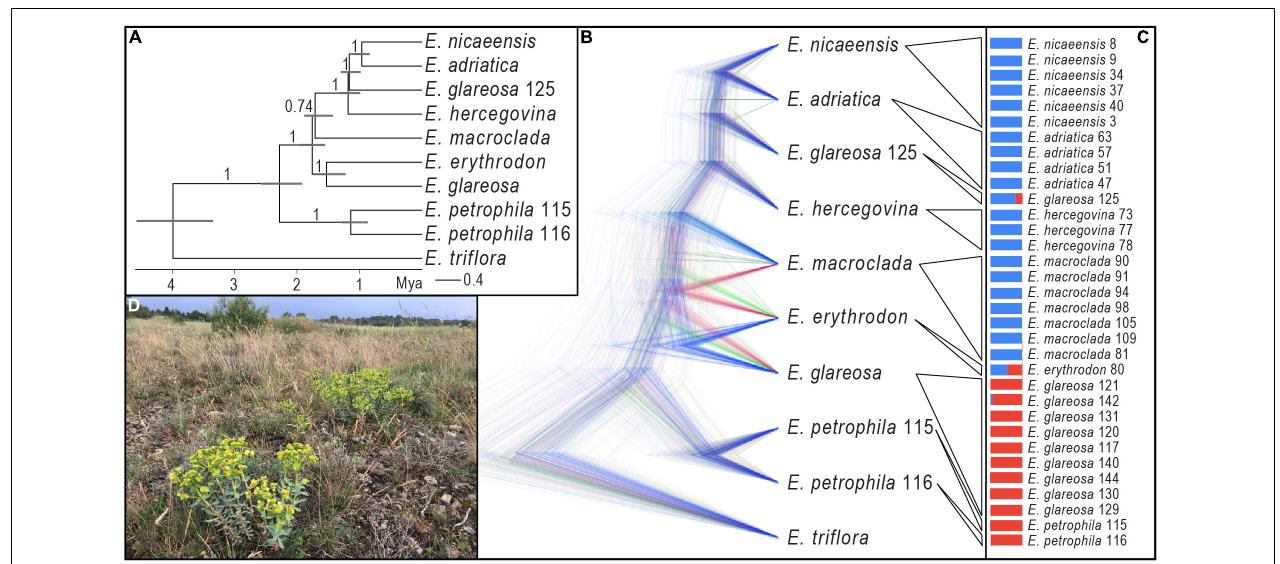
FIGURE 4 | Phylogenetic relationships within the Euphorbia nicaeensis alliance based on RADseq data. (A) The time-calibrated species tree inferred with SNAPP. Numbers above branches are posterior probabilities, and the horizontal bars correspond to 95% highest posterior densities (HPD) of the age estimates. (B) Alternative topologies visualised with DensiTree and represented by different colours. (C) Division of all populations into two groups (blue and red) with Bayesian clustering using fastSTRUCTURE. (D) Euphorbia nicaeensis in its natural habitat northwest of Carcassonne in France (Photo: B. Frajman). Population numbering corresponds to Supplementary Table 1